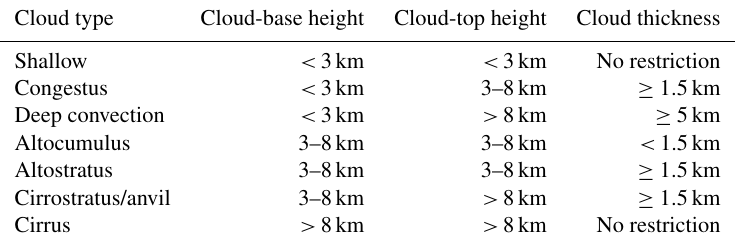
Table 1. Cloud-type definitions based on cloud boundaries and thickness. Definitions are slightly modified from Burleyson et al. (2015) (their Table 2) and McFarlane et al. (2013) (their Table 3).